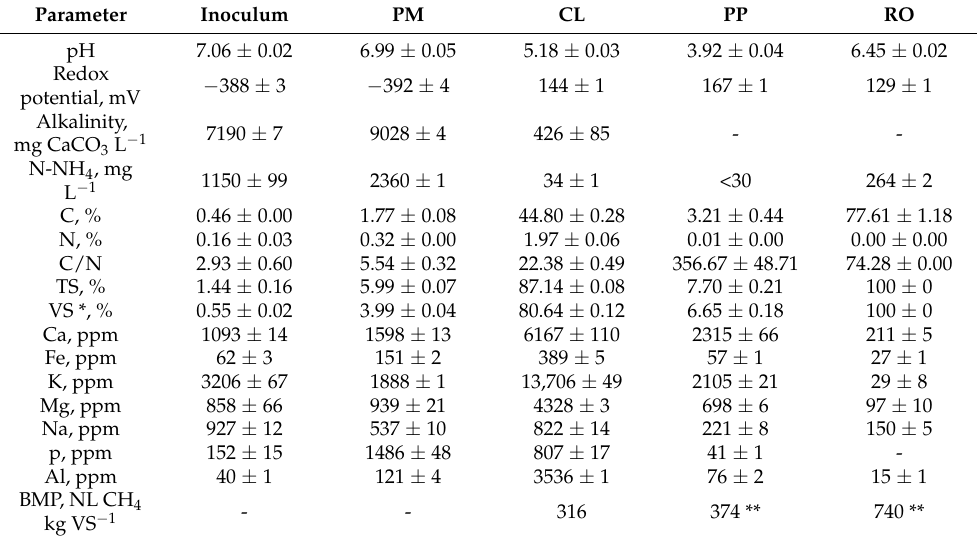
Table 2. Chemical parameters of raw materials